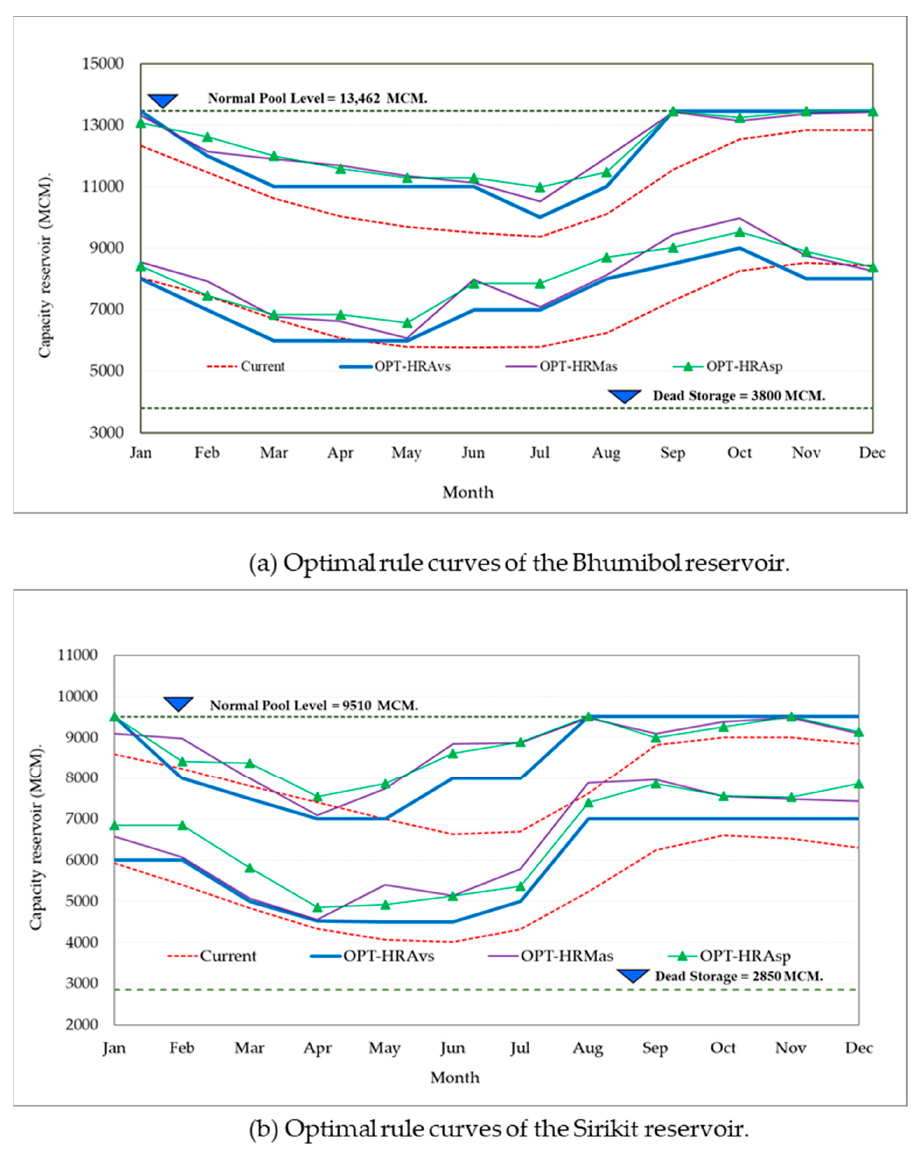
Figure 13. The obtained rule curves based on the proposed optimization techniques.